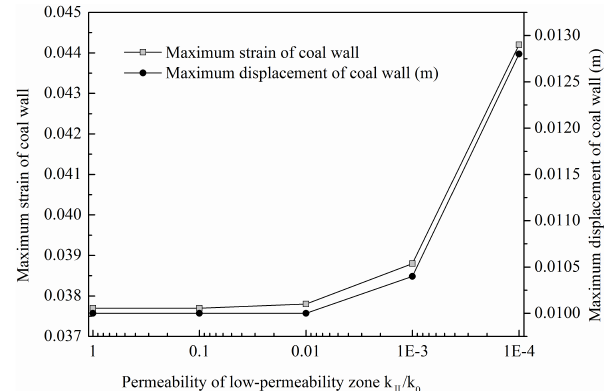
Figure 10. Deformation of coal wall. 3